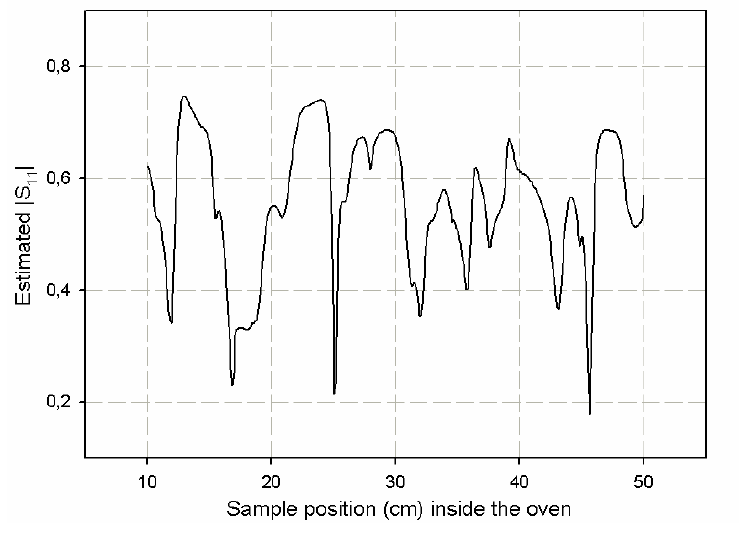
| response versus sample position within the multimode Figure 18. |S 11